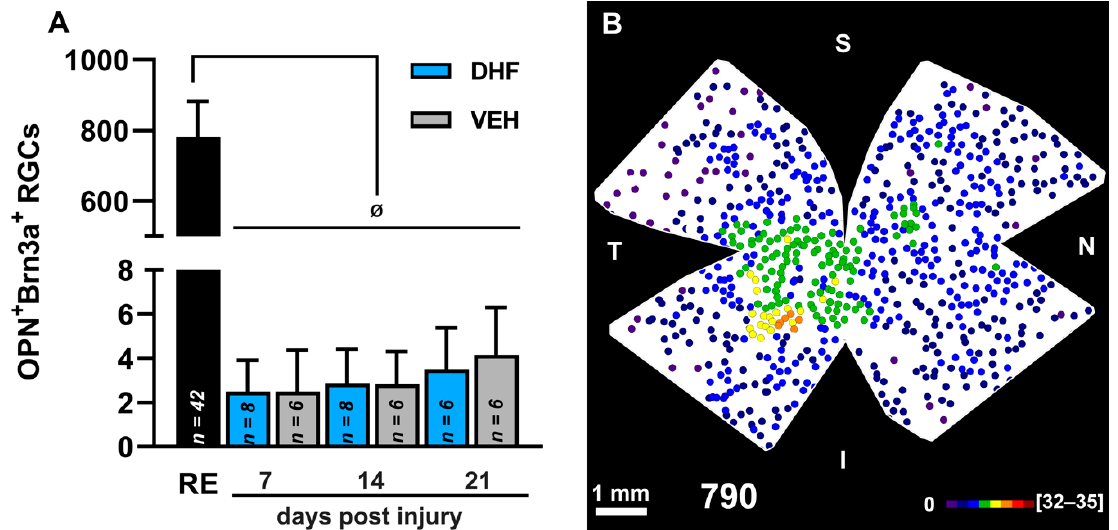
Figure 6. DHF prevents IONT-induced OPN + RGC loss. In adult albino rats, the left optic nerve was intraorbitally tran- sected and animals were treated i.p. daily with vehicle (VEH) (1% DMSO in 0.9% NaCl) or DHF (5 mg/kg) starting from one day before IONT until processing, and analyzed at 7, 14 or 21 days to determine survival of RGCs labelled with Oste- opontin (Opn + RGC). ( A ) Bar histogram showing mean total numbers of OPN + RGCs in right fellow (RE) and the loss and neuroprotection of OPN + RGCs in left experimental retinas of rats treated with DHF or VEH ( n for each experimental group analyzed at different days post injury are indicated in the corresponding bar of the histogram). One-way ANOVA * p < 0.05, differences between DHF and VEHICLE treated group. One-way ANOVA Ø p < 0.05, differences between control and the experimental groups. ( B–E’ ) Representative neighbor maps showing Opn + RGC topography in an untouched contrala- teral retina ( B ), and in retinas treated with DHF ( C , D , E ) or VEHICLE ( C’ , D’ , E’ ), analyzed at 7 ( C,C’ ), 14 ( D , D’ ) or 21 ( E , E’ ) days. Isodensity maps illustrate the neuroprotective effects of DHF over the population of Opn + RGCs when compared to vehicle at seven and 14 days. Below each map is indicated the total number of OPN + RGCs counted for that retina. S: superior, N: nasal, I inferior, T, temporal. Neighbor maps color scale from 0 to 4 (purple) to ≥ 32–35 (red) neighbors in a radius of 0.276 mm. Scale bar 1 mm.